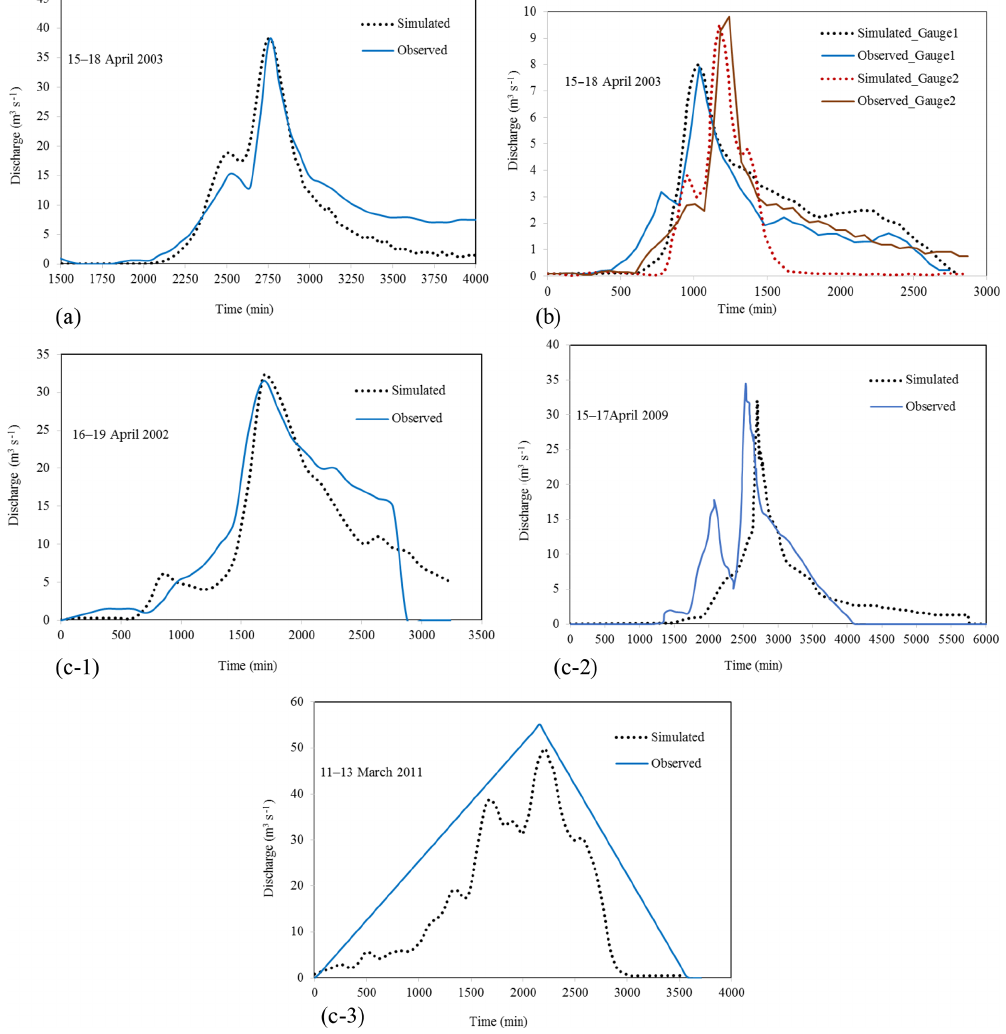
Figure 4. The observed and simulated flood hydrographs in (a) the calibration step at Sulaghan station (15–18 April 2003), (b) the calibration step at upstream gauges (15–18 April 2003), and (c) the verification step at Sulaghan station (16–19 April 2002, 15–17 April 2009, and 11– 13 March